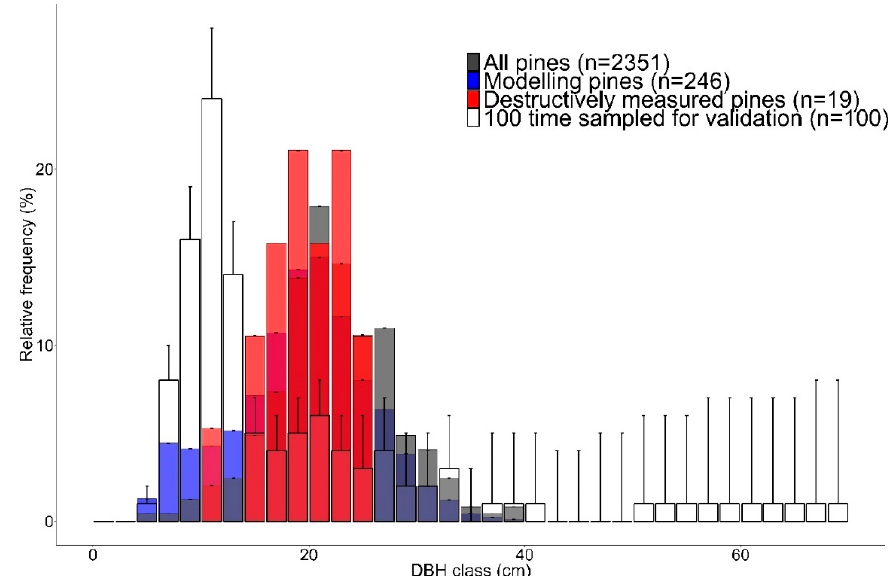
Figure 5. Distributions of diameter at breast height (DBH) classes of all Scots pines in 37 sample plots within the study area (grey), Scots pines used for parametrizing the taper curve (i.e., modelling pines) (blue), and Scots pines used for validating the reliability of parametrized taper curve equations (red). Additionally, distribution of Scots pines with TLS-based taper curves randomly sampled 100 times (without replacement) and their variation (error bars display standard deviation).